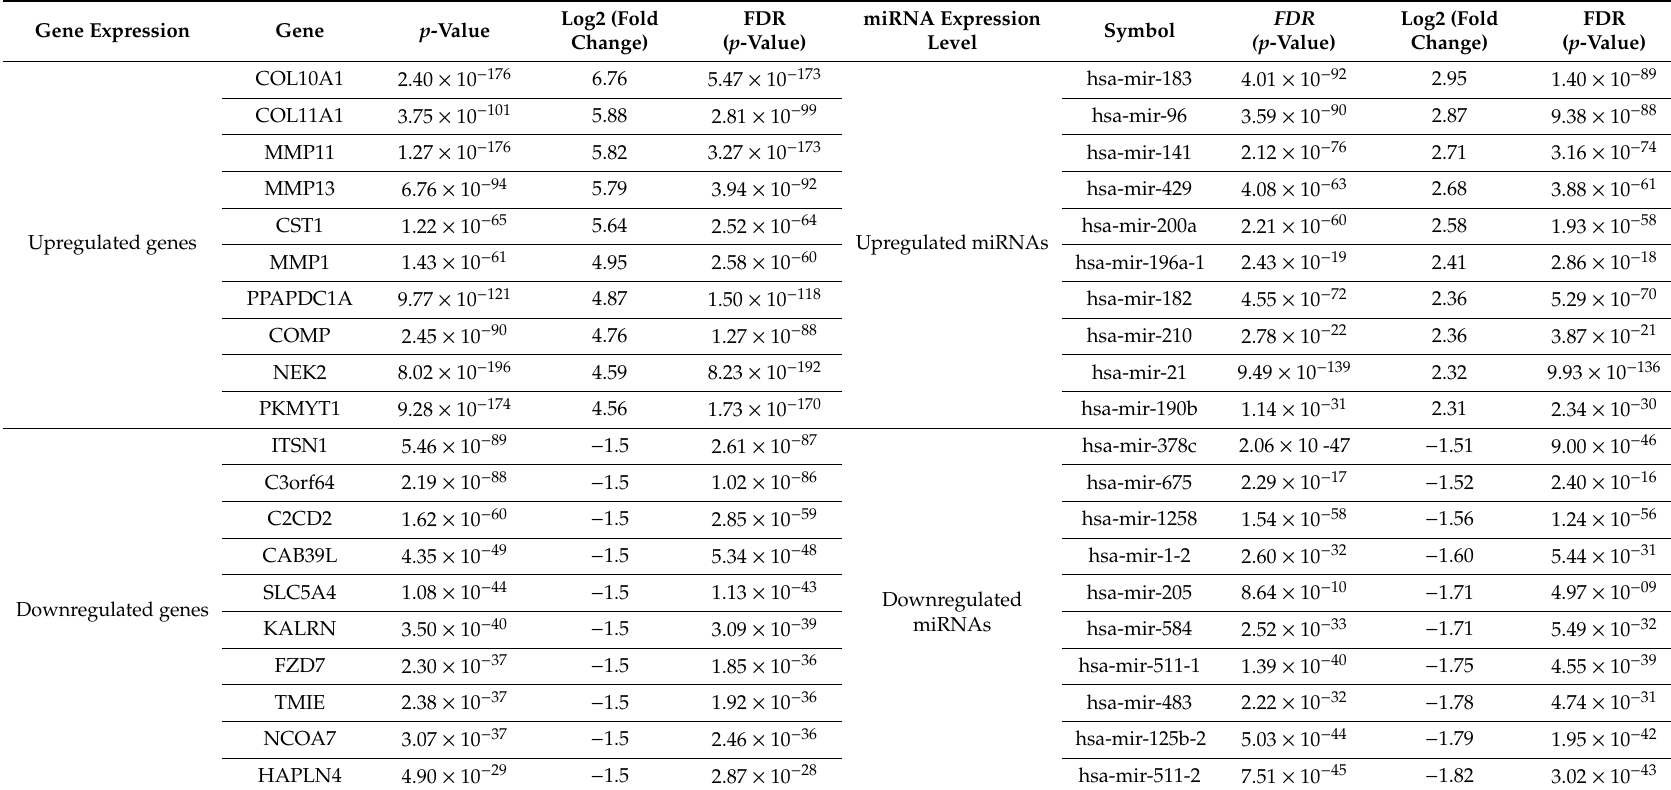
Table 1. Top 10 upregulated and downregulated genes and